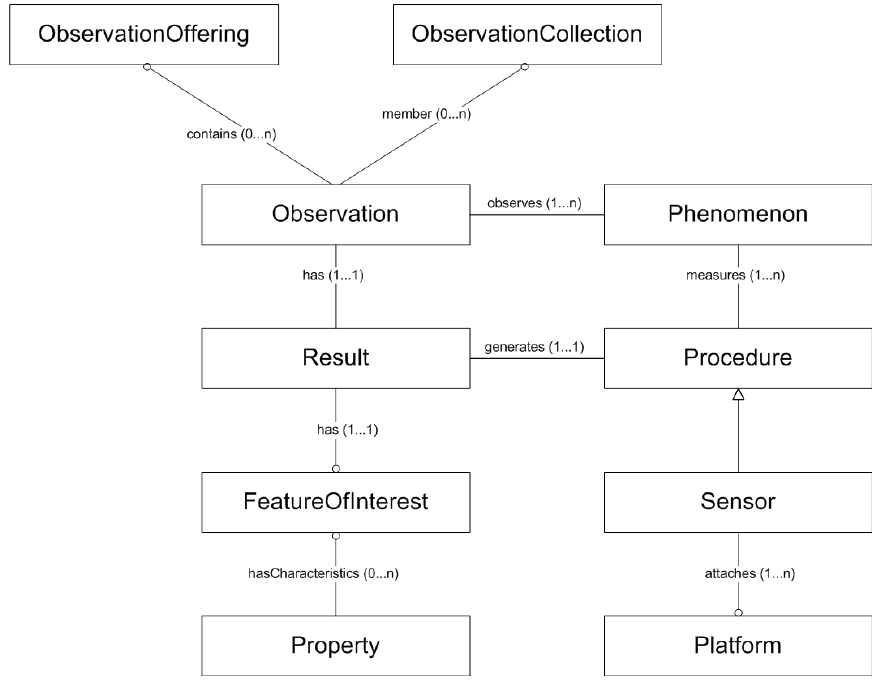
Figure 9. OGC Data Model for